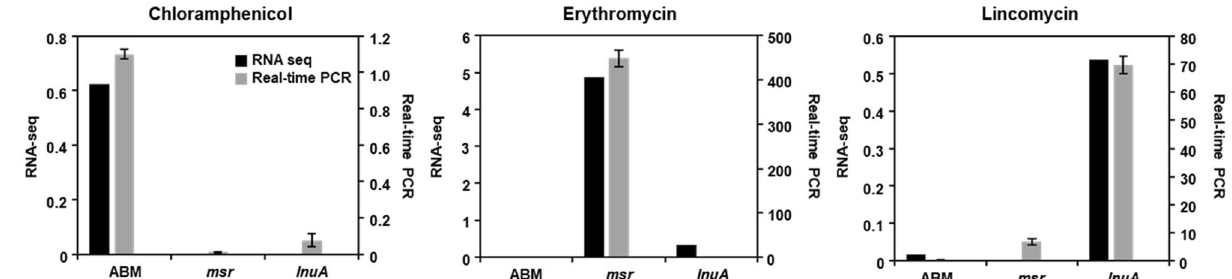
Figure 5. Validation of RNA sequencing data by quantitative real-time PCR (qRT-PCR). Genes related to resistance to chloramphenicol, erythromycin, and lincomycin were selected for validation under different antibiotic pressures. Data are expressed as log 2 fold-changes in gene expression between control and antibiotic- treated samples. In qRT-PCR, 16S rRNA gene expression was used for normalization of target gene